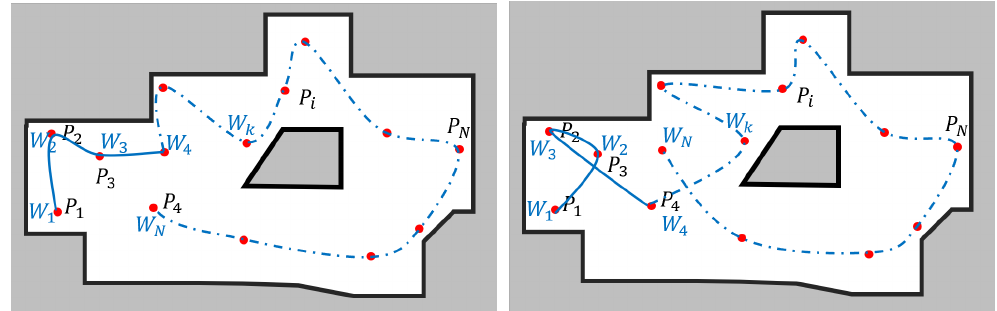
Figure 4. Examples for waypoint sequences that can be followed by the robot for auditing